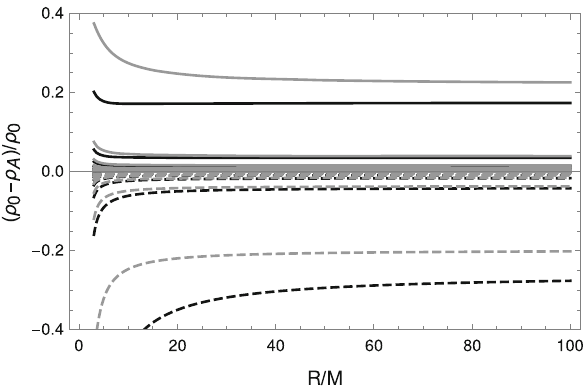
Fig. 5 The discrepancy between the average energy density ρ 0 in the inhomogeneous model and the estimated energy density in the homo- geneous model ρ A as a function of compactness parameter R / M . The black/gray lines correspond to a phase σ = 1, σ = − 1, respectively. The solid/dashed lines correspond to the outermost inhomogeneity being overdesnity, underdensity, respectively. The curves were plotted for n = 1 , 3 ,..., 21. The amplitude of the effect of